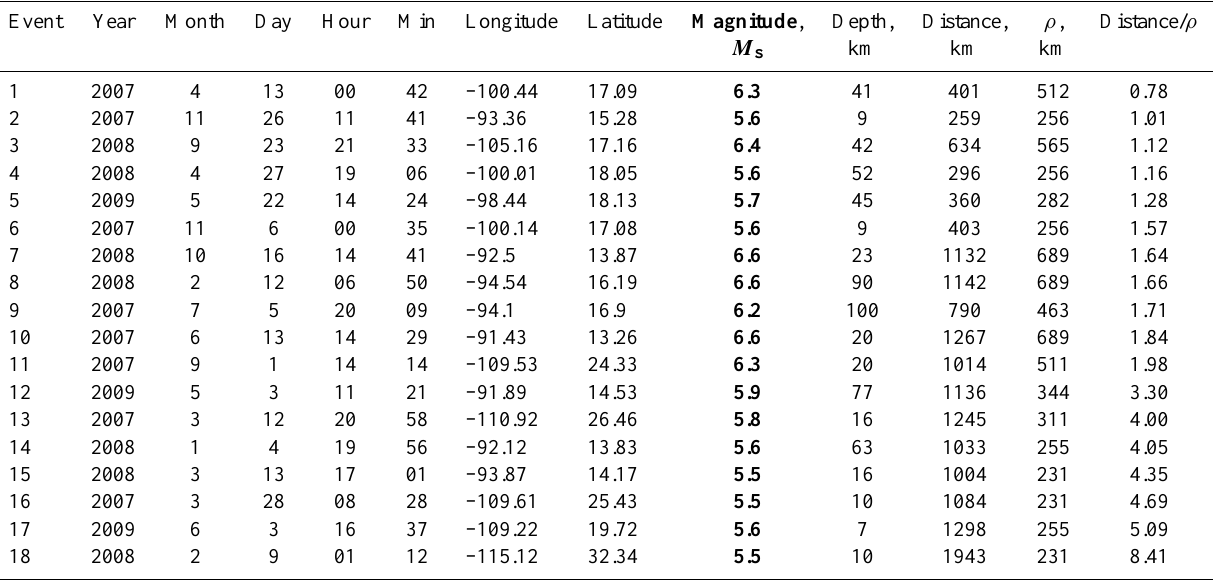
Table 1. Earthquakes occurred in Mexico during 2007–2009 selected for this analysis. Year/month/day/hour/min are: the exact time of the EQ (Local Time); Latitude and Longitude: the geographic coordinates of the epicentre, magnitudes and depth: magnitude and depth of the EQ, Distance: the distance between the epicentre and Juriquilla station, ρ : is the radius of the EQ preparation zone estimated by Dobrovolsky equation. The EQ magnitudes are presented in bold.